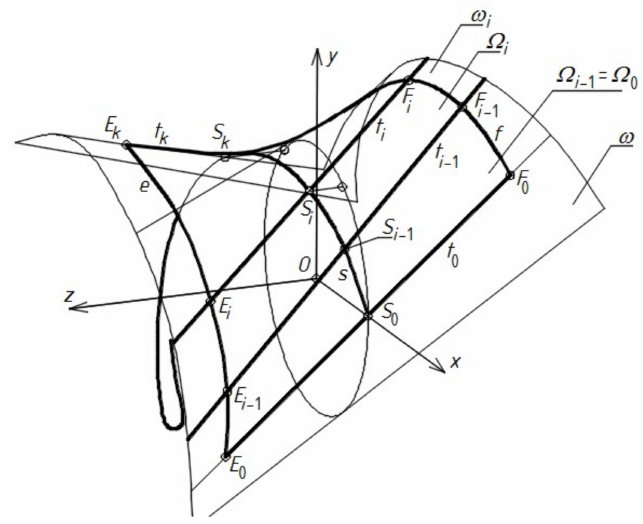
Figure 14. Sector Ω of warped surface ω modeling effectively transformed shell roof by means of contraction helix s ( S 0 , . . . , S i , . . . , S k ) of Ω